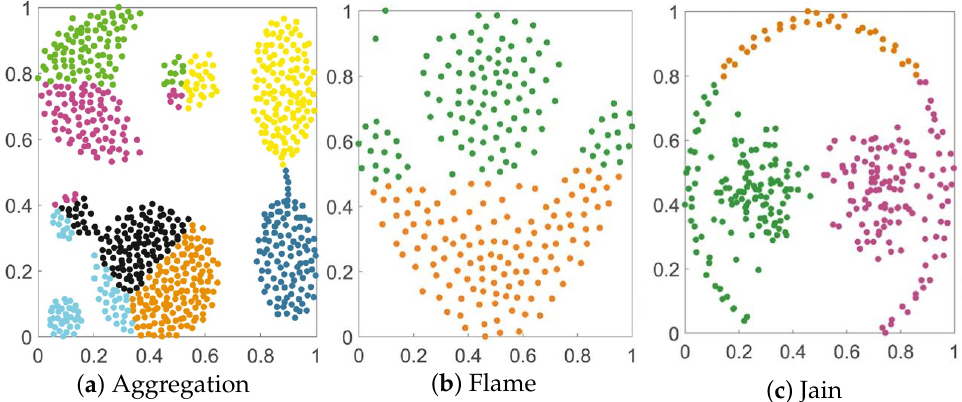
Figure 6. Clustering effect of the FCM algorithm on Aggregation, Flame, and Jain.